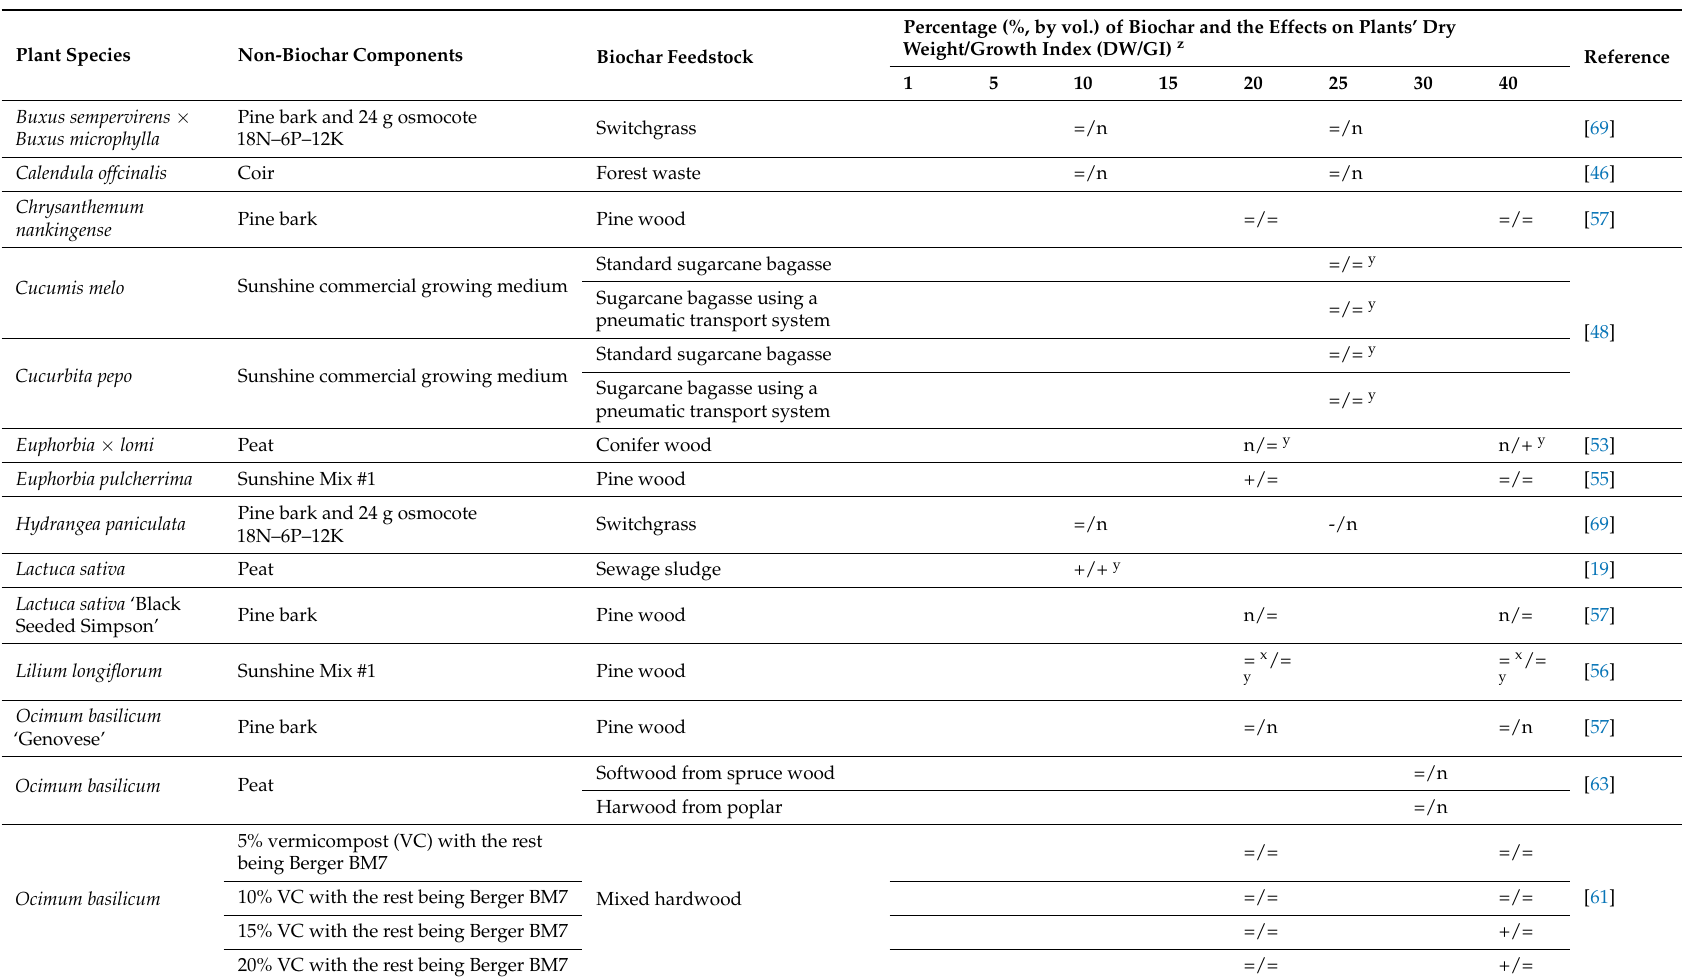
Table 2. Summary of the effects of biochar made from different feedstocks mixed with other substrate components on container-grown plants, with percentage of biochar in container substrates less than 50% (by